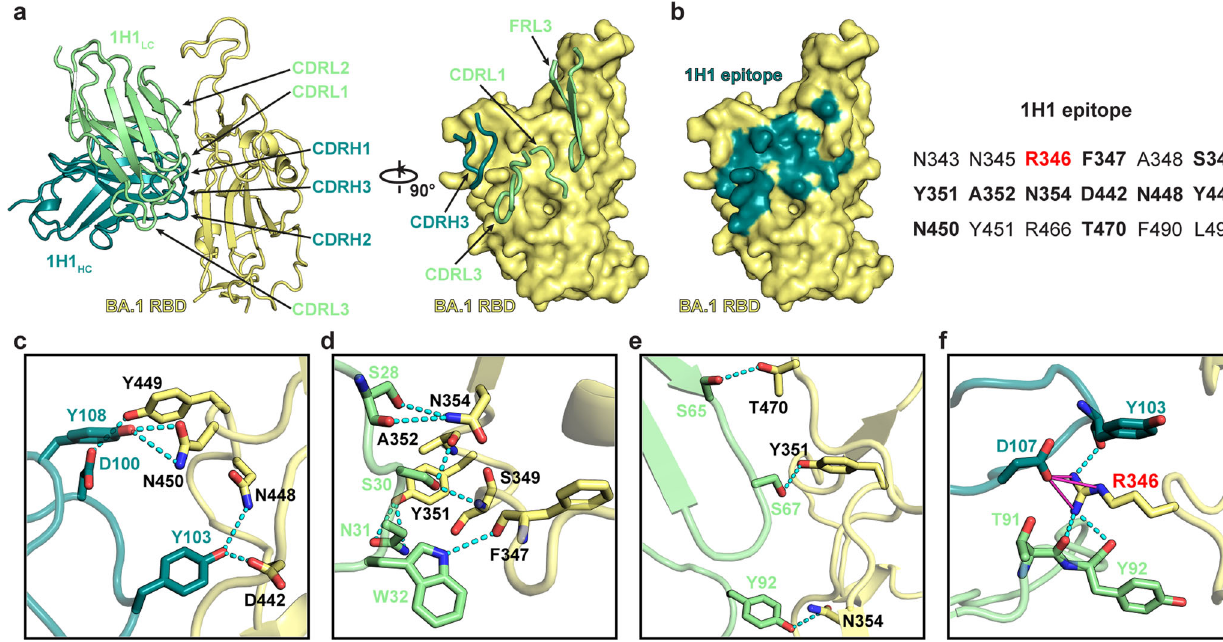
Fig. 4 Structural details of interactions between the BA.1 RBD and 1H1 Fab for potent and broad neutralization. a overall structural model of BA.1 RBD in complex with 1H1 Fab and its CDRs are labeled. b the footprints of 1H1 are represented as surface and colored with dark cyan. The BA.1 RBD residues recognized by 1H1 are listed and a key interaction residue R346 of the BA.1 RBD is colored red. c – f the detailed interactions between the BA.1 RBD and 1H1 Fab including 1H1 heavy chain ( c ), 1H1 light chain ( d , e ) and the key residue R346-related interactions ( f ). The interacting residues of BA.1 RBD are shown as yellow sticks, the 1H1 heavy chain residues are shown as dark cyan sticks and the light chain residues are shown as light green sticks. Potential hydrogen bonds are represented as cyan dashed lines and salt bridges are represented by magenta lines,